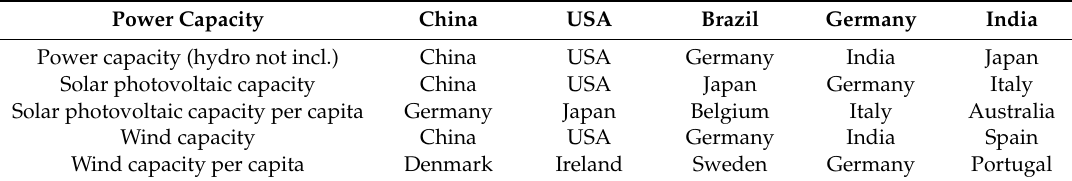
Table 1. Power capacity 2017 top five.